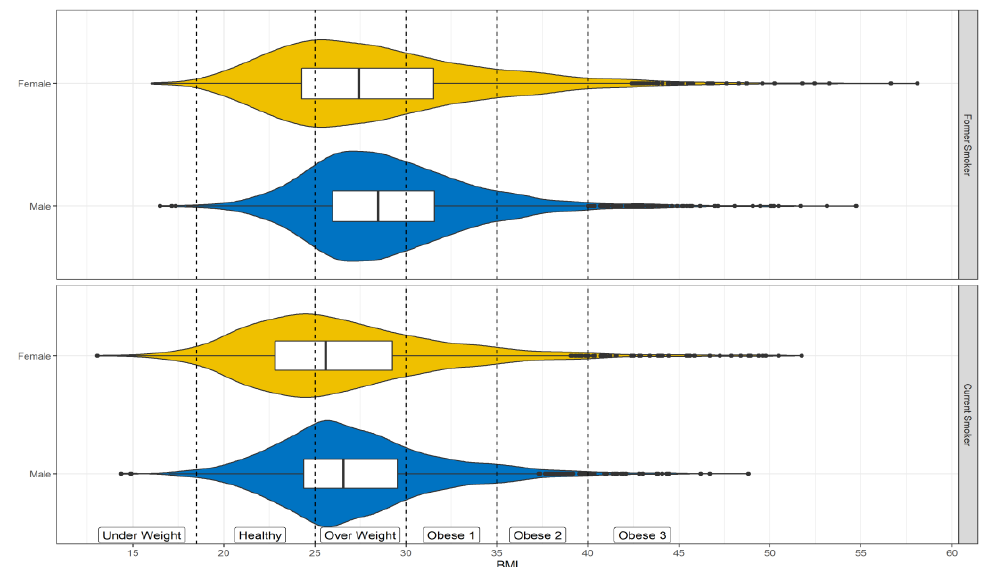
Figure 2. Distribution of body mass index (BMI) by gender and smoking status. Dashed lines and labels are the CDC classifications.